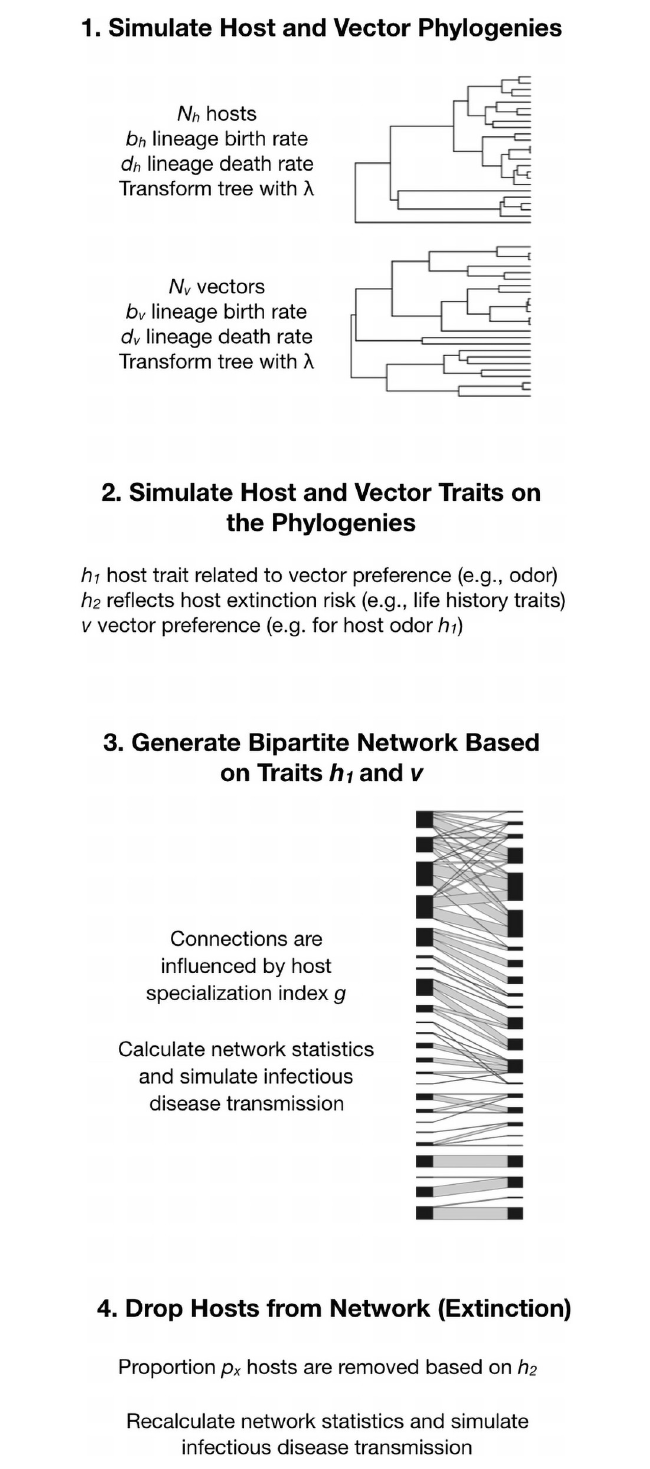
Fig 1. Overview of the modelling approach. The schematic shows the four main steps in the model, labelled 1–4. Note that λ is adjusted to reflect variable phylogenetic signal in the simulated traits, which assumes a Brownian motion model of